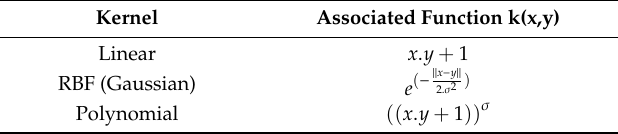
Table A2. Most used support vector machine (SVM) kernels.